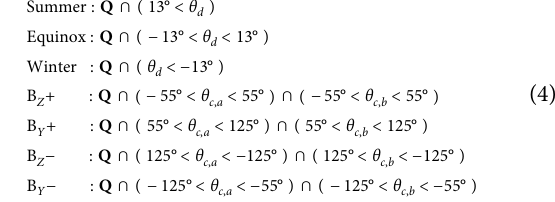
Table 1 summarizes the number of events in the different groups.